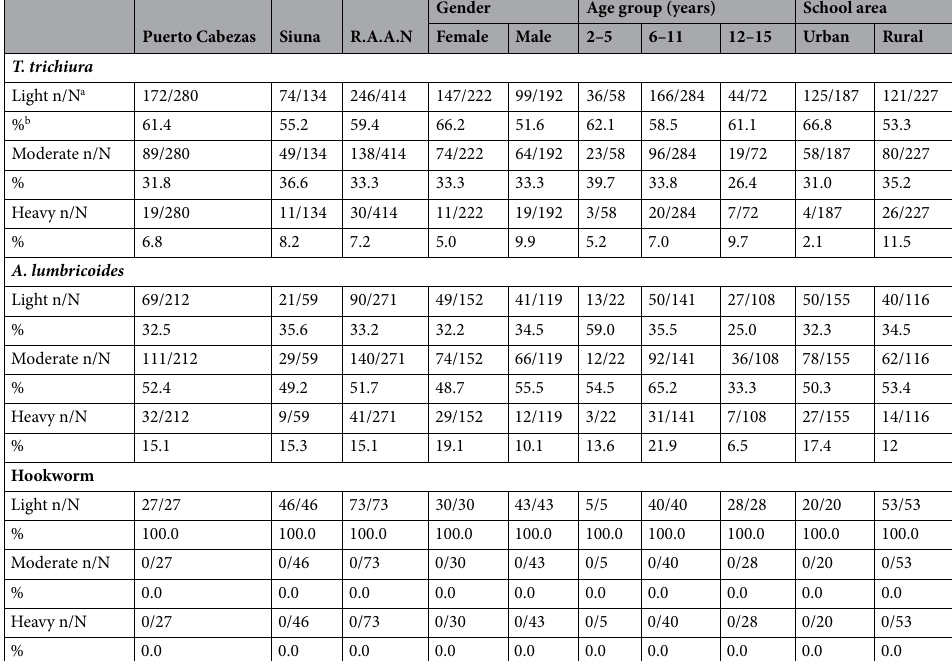
Table 4. Percentage of each class of infection intensity of STH species according to gender, age group and school area obtained in both municipalities studied and in the total R.A.A.N. (Nicaragua). a Positive students/ total students in the group. b Percentage.